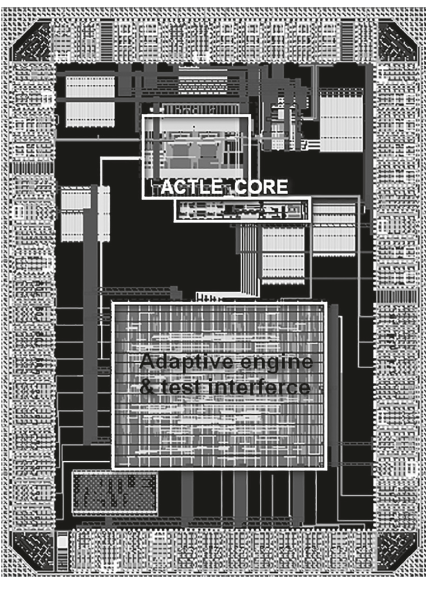
Figure 8: Layout of the chip.